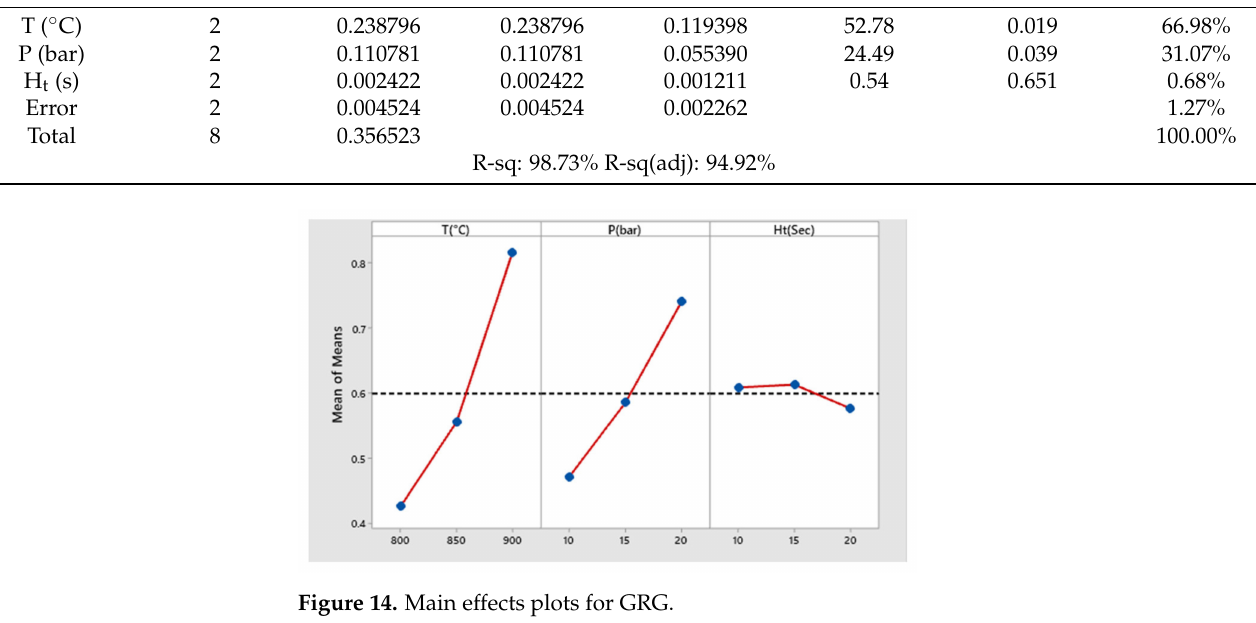
Figure 14. Main effects plots for